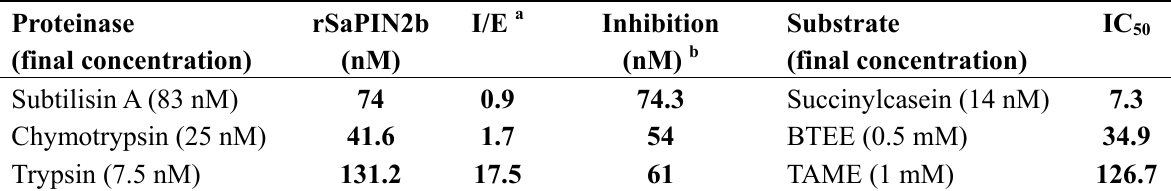
Table 1. The inhibitory effect of rSaPIN2b on the activity of various proteinases.